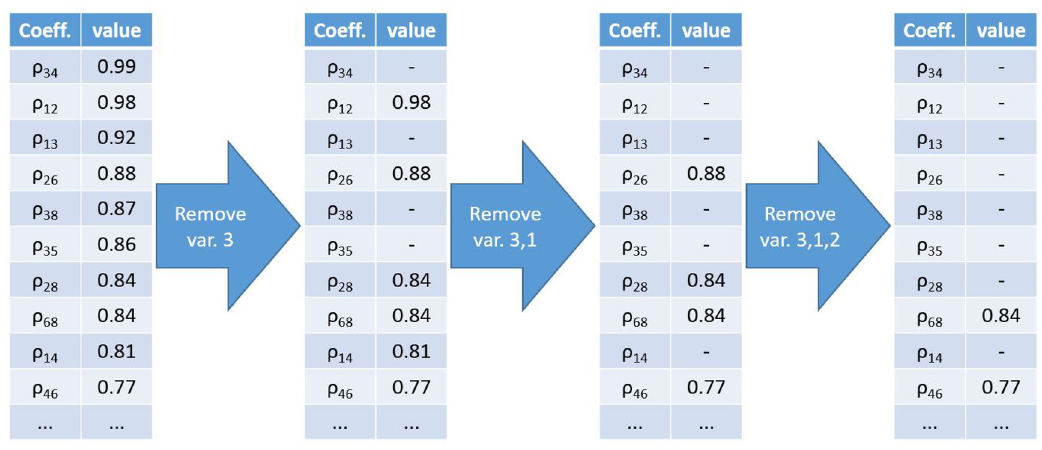
Figure 2 . Graphical description of the CVR procedure available in the preprocessing stage of RanBox and RanBoxIter . The ordered list of absolute values of correlation coefficients among the variables defining the D− dimensional feature space is scanned by searching for all possible combinations of N variables which, once removed, minimize the largest surviving correlation void coefficient. In the figure, for N = 3 the removal of variables 3, 1, 2 (shown in succession for void clarity) reduces the highest surviving correlation most